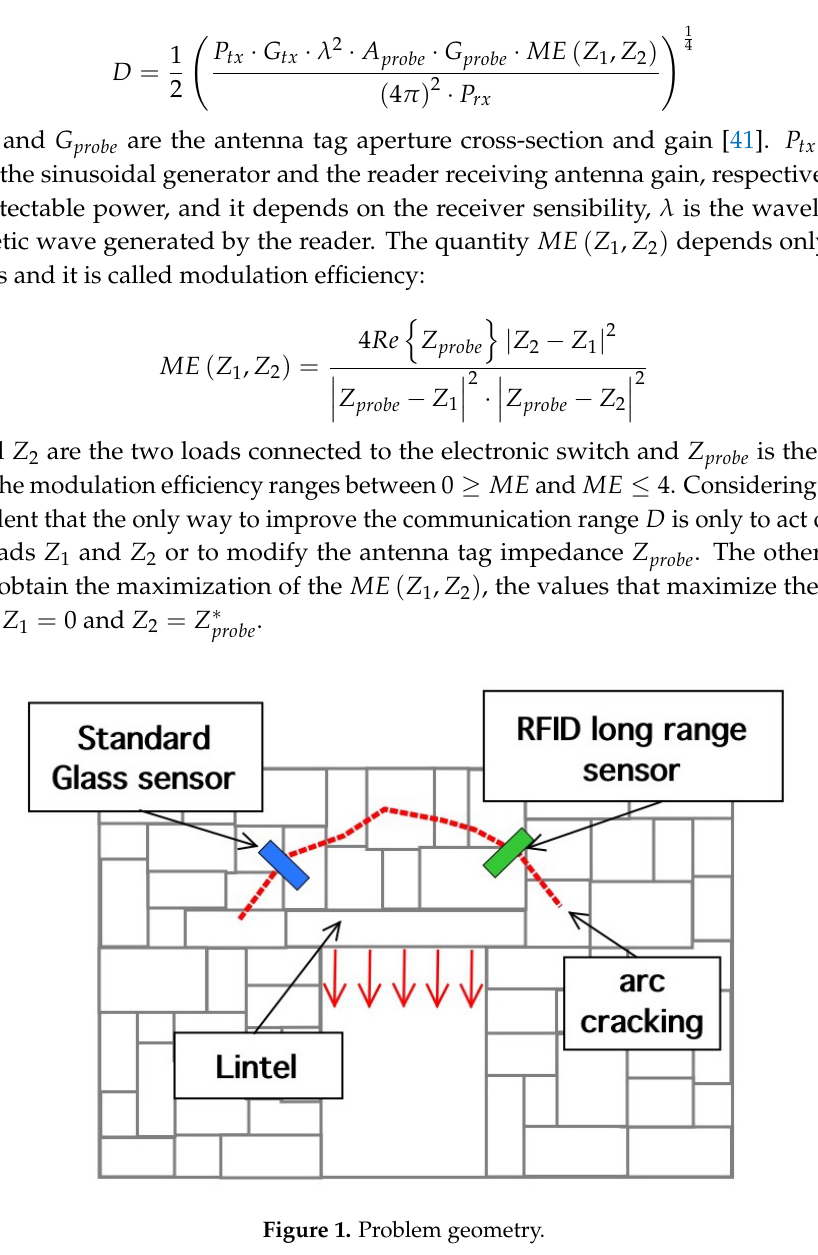
Figure 1. Problem